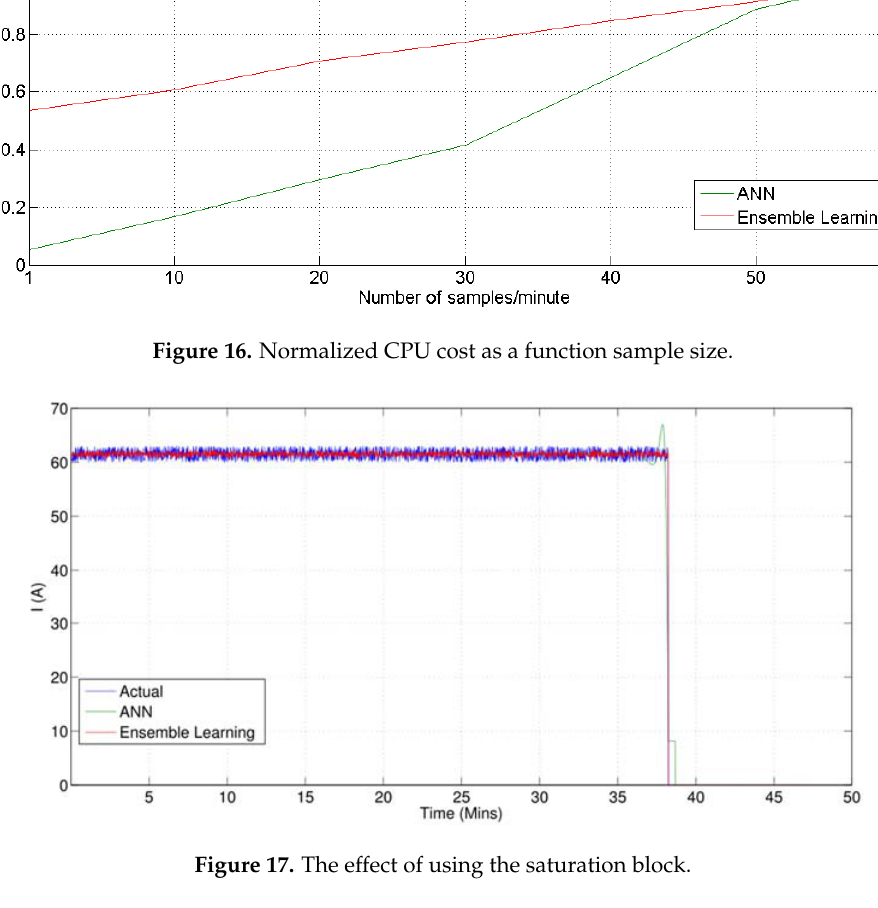
Figure 17. The effect of using the saturation block.